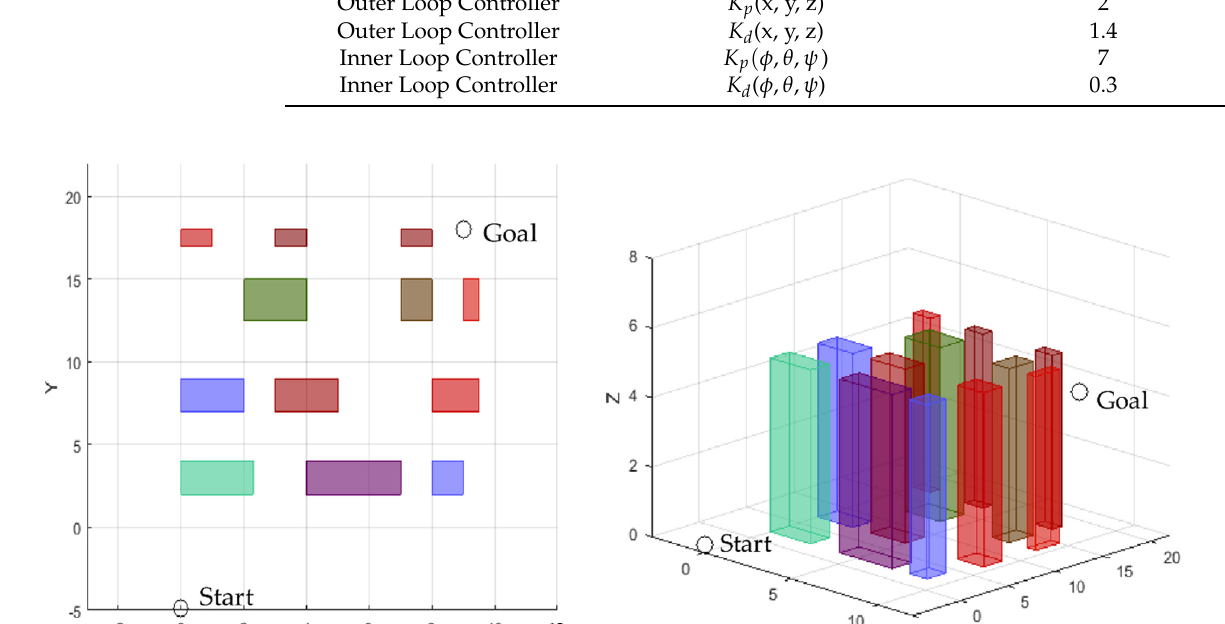
Figure 4. Map containing obstacles and start and goal points (2D and 3D views).